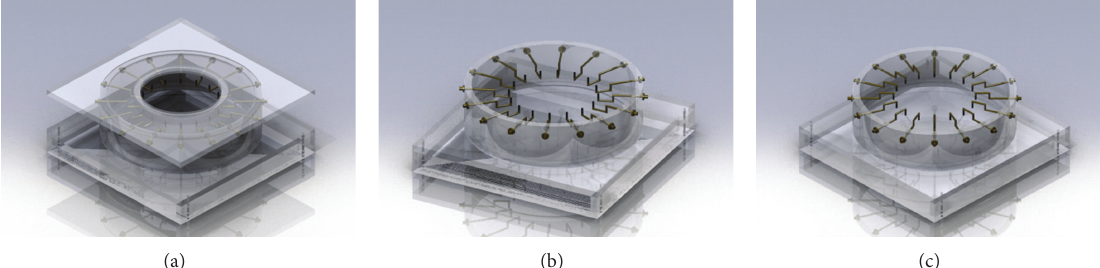
Figure 1: SolidWorks rendering of an example rotary-enabled monopole antenna array: (a) with top cover, (b) with antennas oriented upwards, and (c) with antennas oriented downwards.